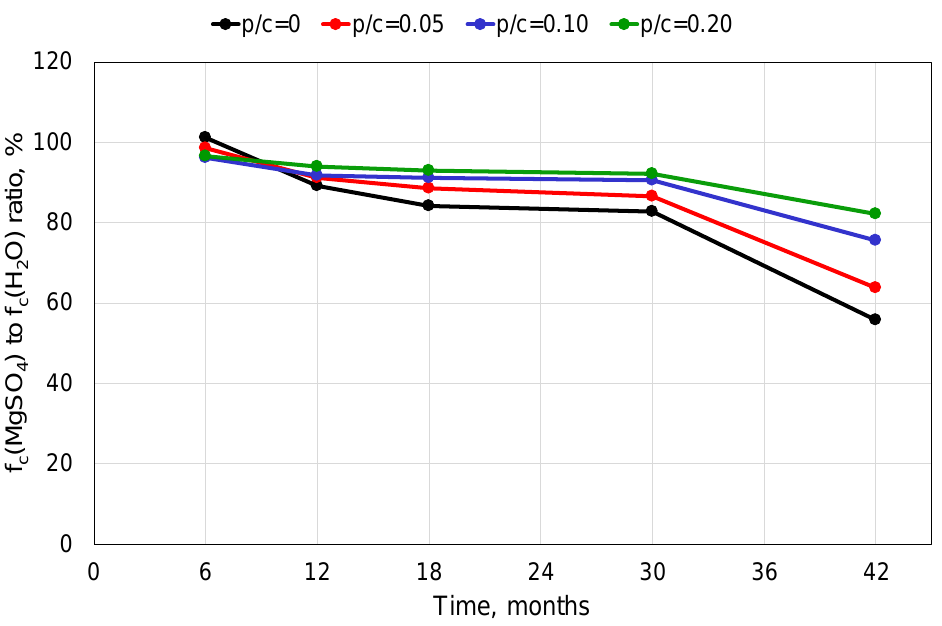
Figure 5. The ratio of compressive strength of mortars stored in 5% MgSO 4 solution to those stored in distilled water after different exposure times, for various polymer contents.